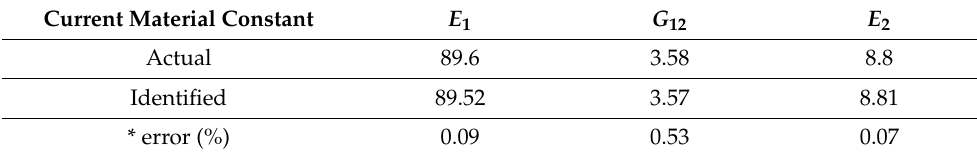
Table 9. Current material constants of graphite/epoxy [0 ◦ ] 8 cantilever plate ( a / h = 120). Current Material Constant